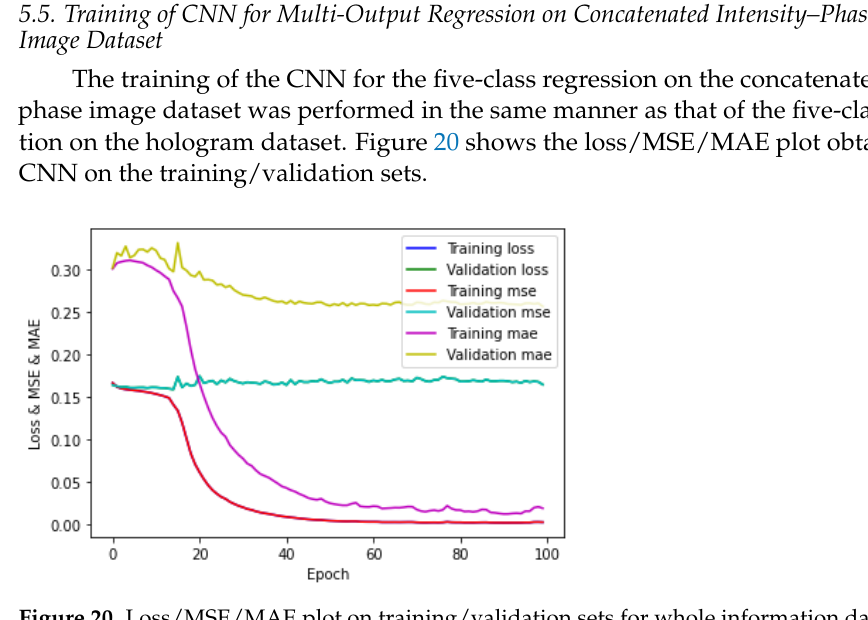
Figure 20. Loss/MSE/MAE plot on training/validation sets for whole information dataset.